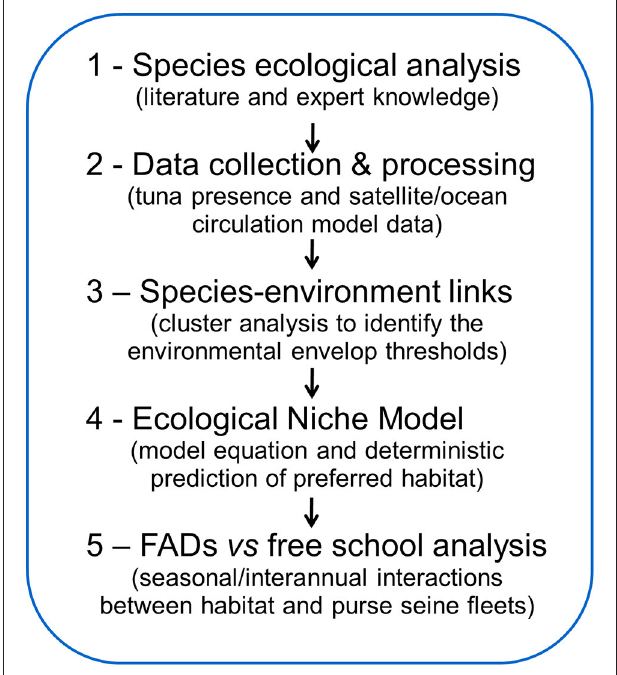
FIGURE 1 | A flowchart of the Ecological Niche Model approach for skipjack tuna (Katsuwonus